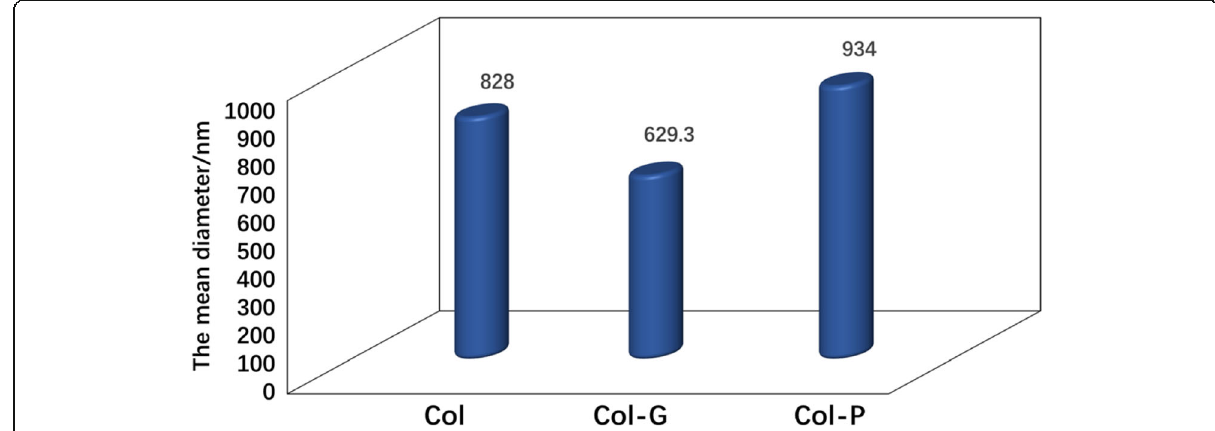
Fig. 6 The mean diameter of collagen aggregates in collagen (Col), collagen-glycerol (Col-G) and collagen-2-propanol (Col-P)